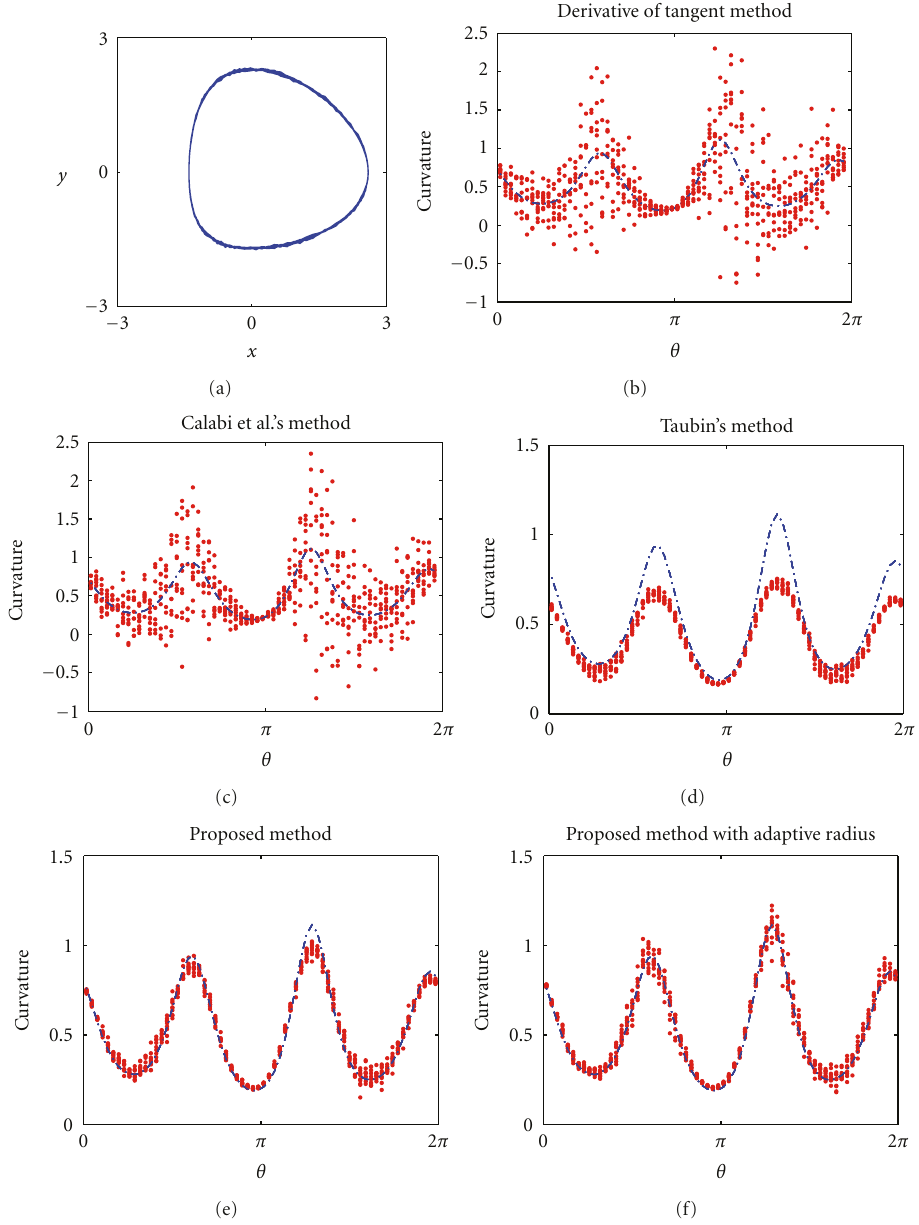
Figure 9: Trial-to-trial variability in curvature estimates. The data consist of 10 trials. (a) The closed curves { x = 2cos θ + (3 / 5)cos 2 θ , y = 2sin θ + (3 / 10)sin 2 θ | θ ∈ [0,2 π ] } with additive Gaussian noise, (b) curvature estimate obtained by derivative of tangent, (c) curvature estimate obtained by Calabi et al.’s algorithm, (d) curvature estimate obtained by Taubin’s algorithm, (e) curvature estimate obtained by line integrals, and (f) curvature estimate obtained by line integrals with adaptive radius. Notice that these figures have di ff erent ranges in vertical coordinate because some methods yield noisy results. The true curvature is denoted by a dashed blue